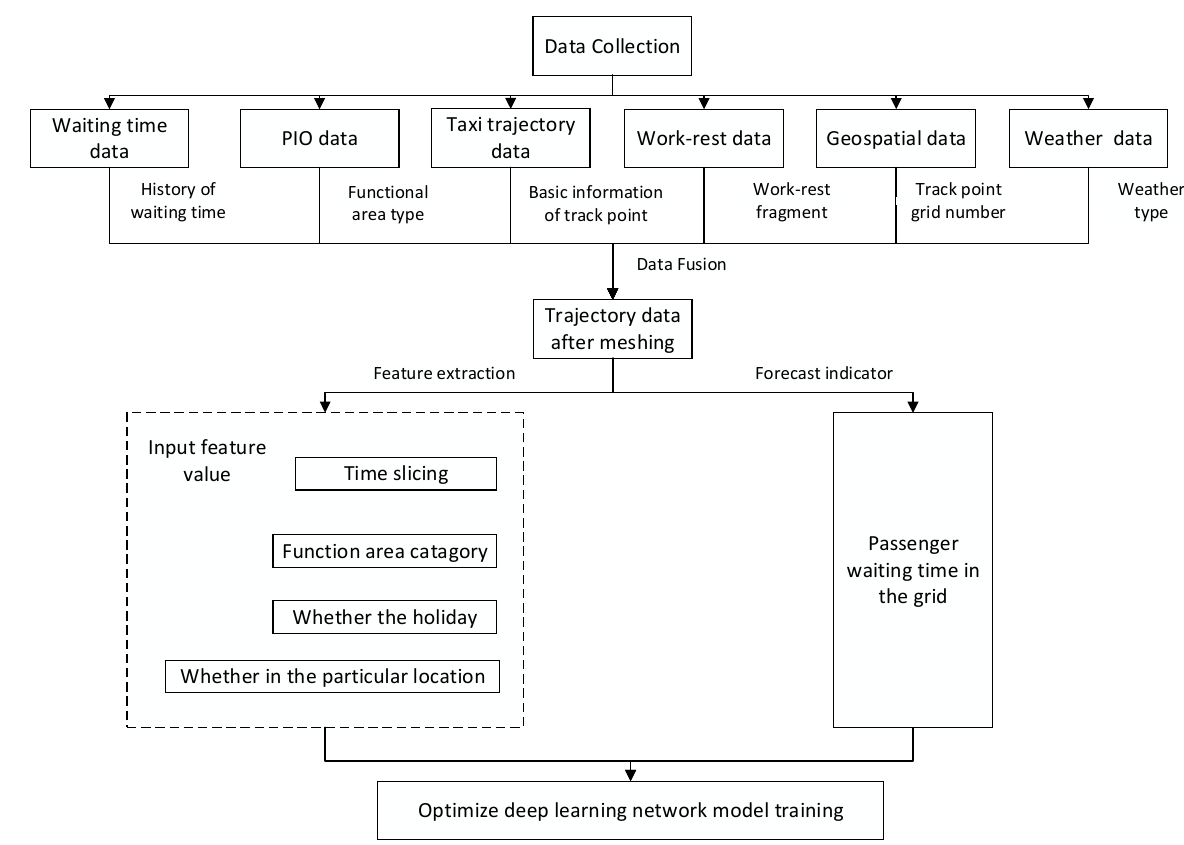
waiting times distributed along the grid spatial and temporal representation of the city. The time–space feature optimization neural network model is shown in Figure 5.